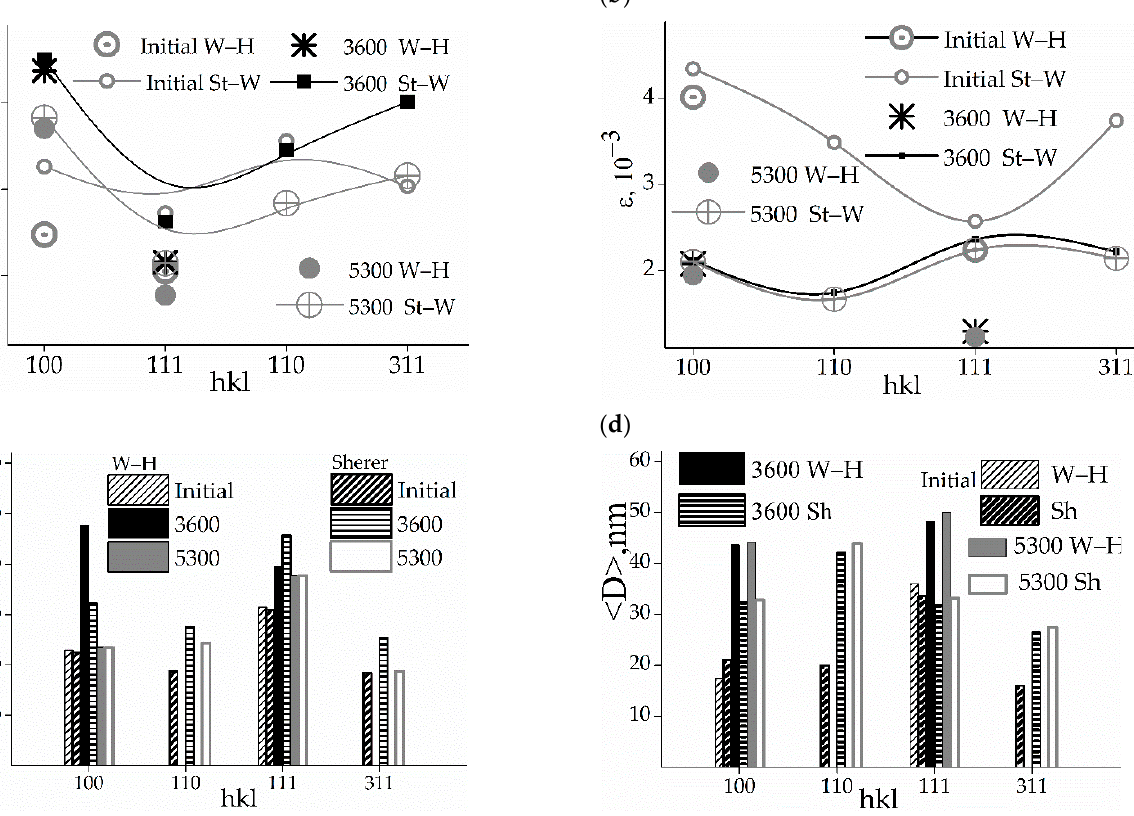
Figure 3. Microstrains in crystallites determined by the Williamson—Hall and the Stokes—Wilson methods [23,24]: ( a , b )—for samples of 5 and 20 wt.% Pb, respectively; and effective sizes <D hkl > of CSR (hkl): ( c , d )—for samples of 5 and 20 wt.% Pb, respectively.